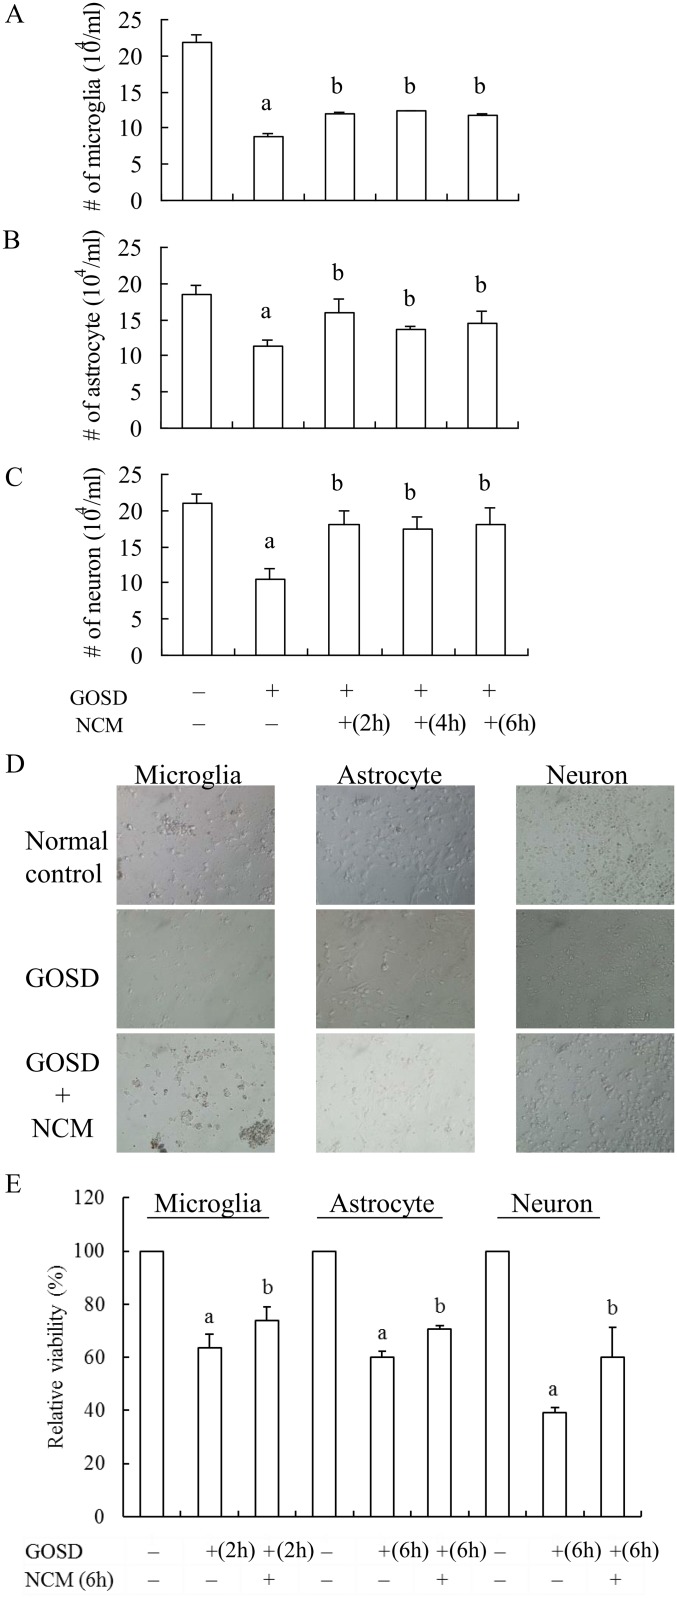
GOSD-induced brain cell injury was inhibited by NCM.NCM collected from neuronal culture (6.4x106/dish in 10-cm dish plates) under GOSD condition for various times (0, 2, 4 or 6 h) was respectively added into microglia (A), astrocytes (B) and neurons (C) and co-incubated for 2 h (microglia) or 6 h (astrocytes and neurons) under the GOSD condition. At the end of incubation, number of the living cells was determined by trypan blue dye exclusion assay (A, B and C) and cell viability also by MTS assay (D). Morphological images of the treated brain cells in D were also captured under the light microscope (E). The magnification of images is 400X. aSignificant difference between lanes 1 and 2; bbetween lane 2 and the indicated lanes, p<0.05. Each experiment was repeated for at least 3 times.